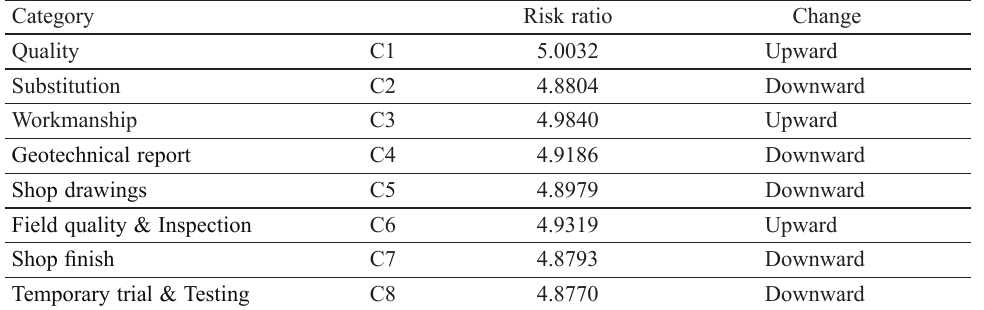
Table 6. AHP sensitivity